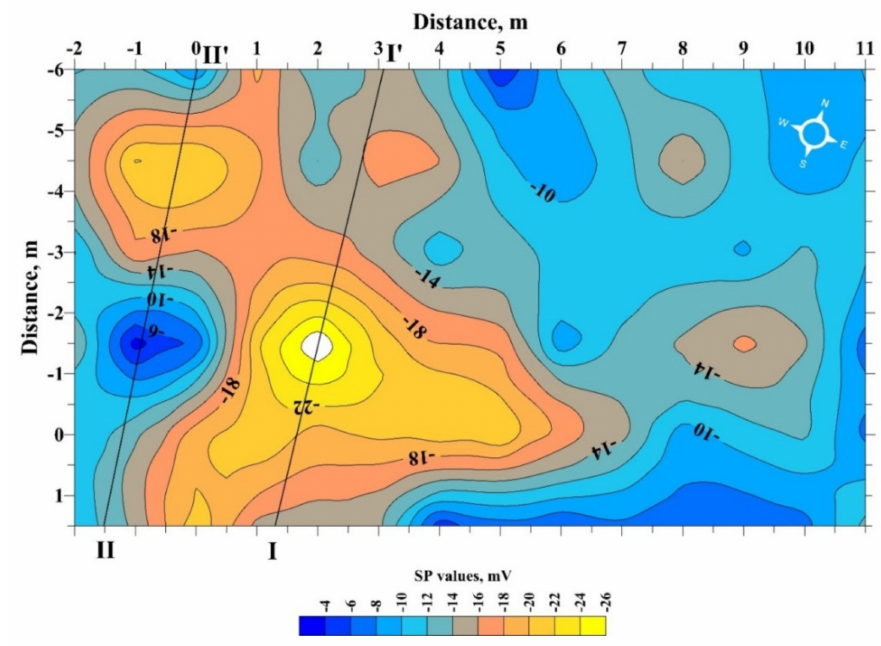
Figure 12. Self-potential map observed in the Banias site (northern Israel) and location of interpreting profiles I—I’ and